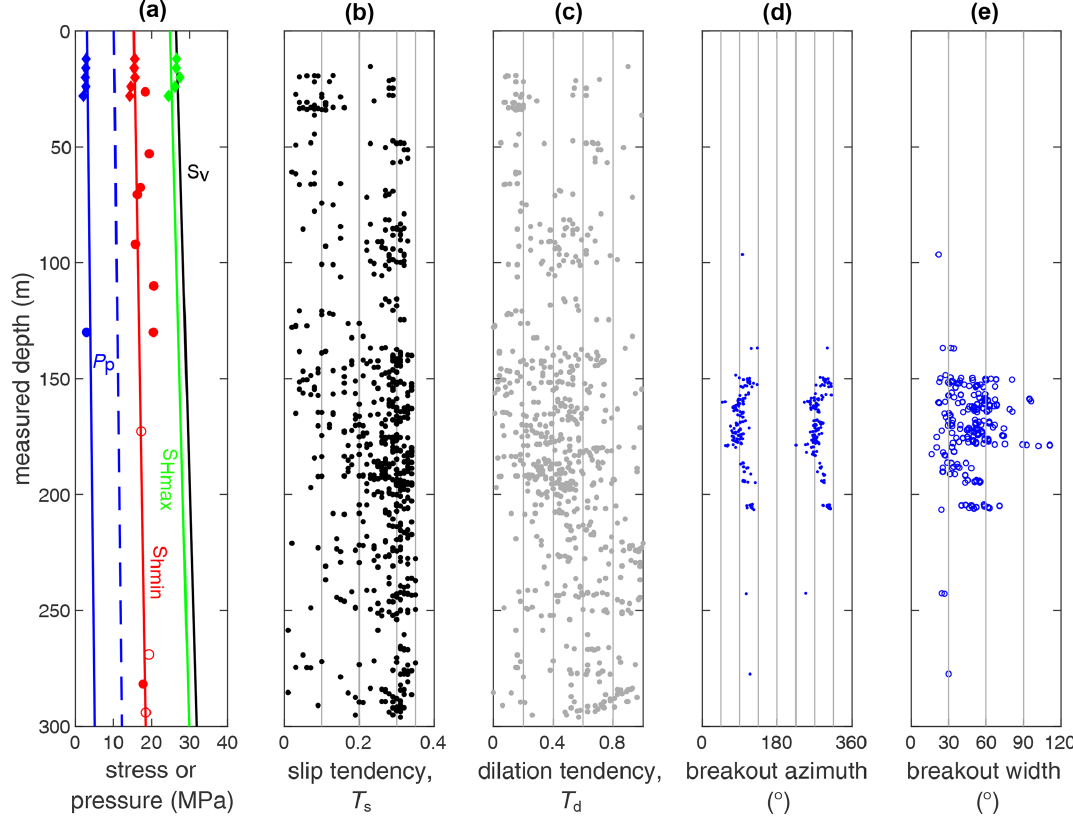
Figure 8. Integrated geomechanical information of borehole CB1: (a) stress and pore pressure profiles (diamonds are from SB borehole data; circles are from CB1, while open circles are of uncertainty; dashed blue gradient represents hydrostatic pore pressure); (b) slip tendency ( T s ) and (c) dilation tendency ( T d ) of all mapped structures (shown in Fig. 5); (d) breakout azimuths and (c) widths (0 ◦ refers to the high side of the